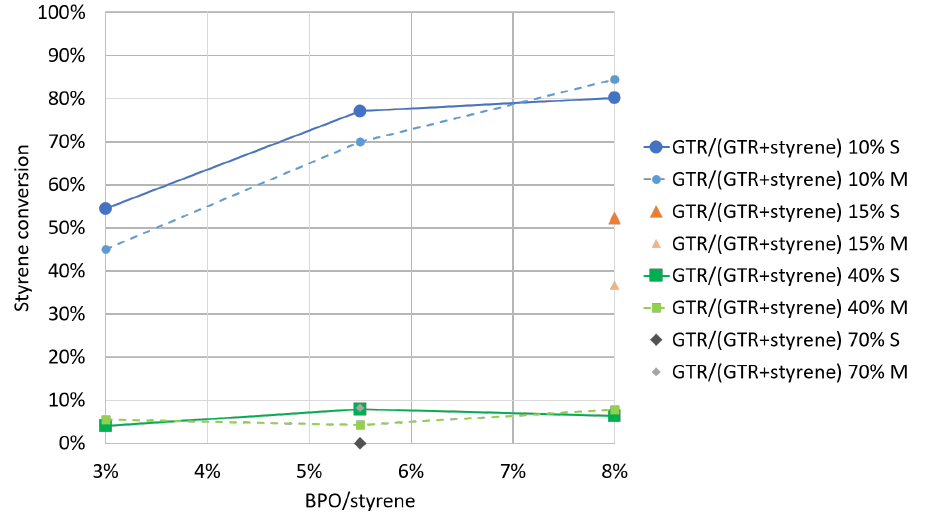
Figure 6. Comparison of small- (S) and medium- (M) sized systems at 100 °C. Figures 7 and 8 depict the combined effect of GTR content and reaction temperature, for a constant amount of initial BPO concentration, on the measured styrene conversion.